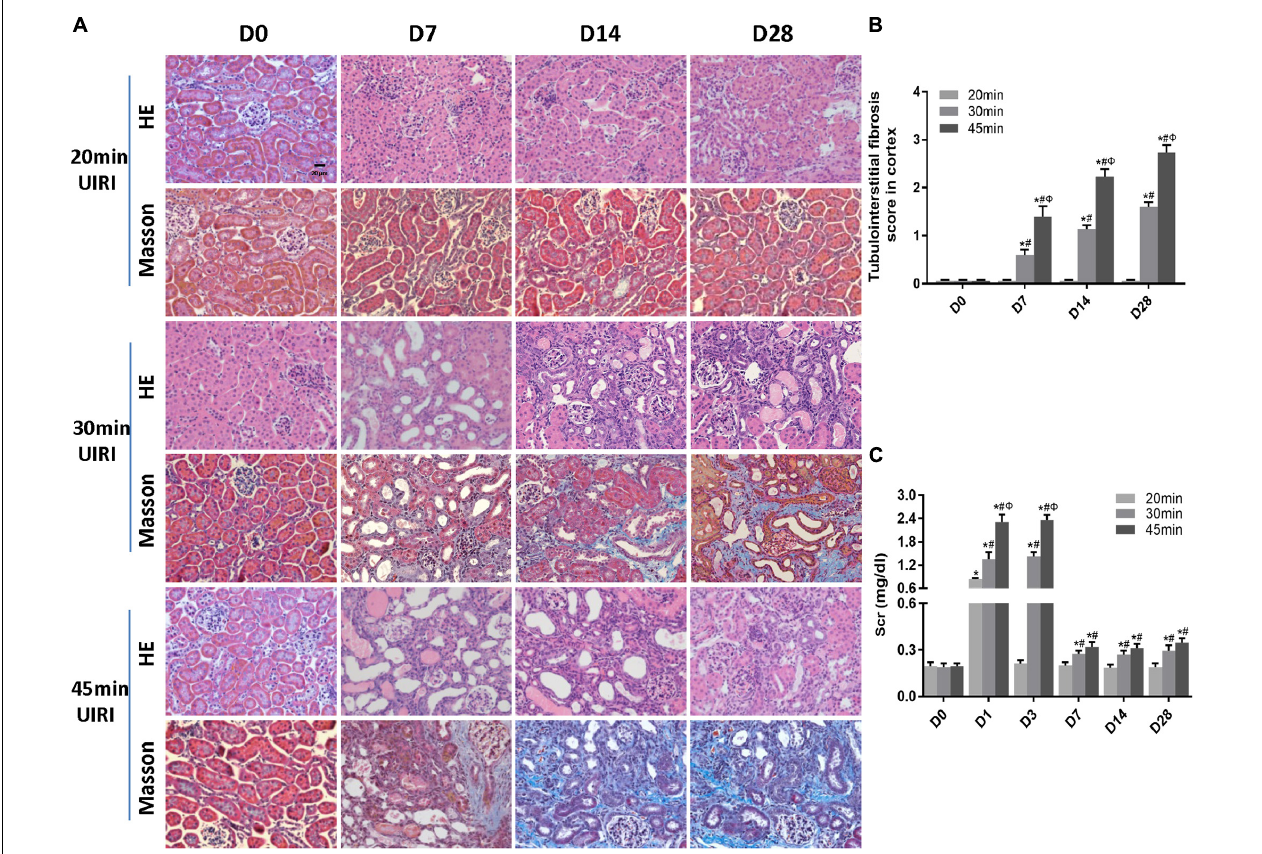
FIGURE 2 | A long ischemia duration induced AKI-to-CKD transition in IRI mice. (A) HE and Masson staining of kidneys during the chronic phase of kidney injury (original magnification × 400; Scale bar, 20 µ m). (B) Tubulointerstitial fibrosis scores of mouse kidneys during the chronic phase of kidney injury. (C) Changes in Scr levels in mice in 28 days post ischemia. Data are presented as the means ± SEM of four experiments. n = 6; ∗ P < 0.05 vs. the control group. # P < 0.05 vs. the 20 min-ischemia group. (cid:56) P < 0.05 vs. the 30 min-ischemia